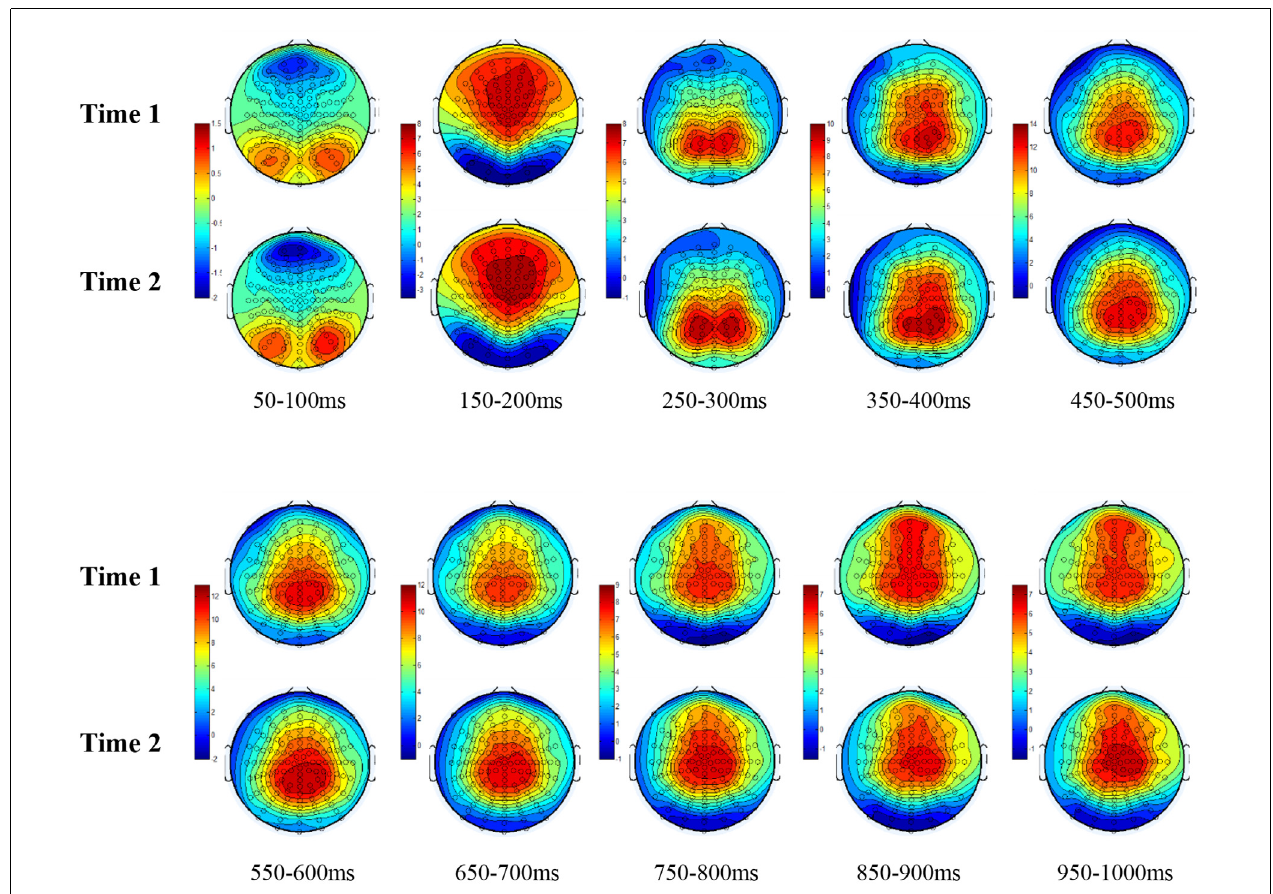
FIGURE 3 | Topographic maps of the mean amplitude for every other 50 ms interval (beginning 50–100 ms) of novelty processing at Time-1 vs. Time-2 (Note that the scales are different across the time